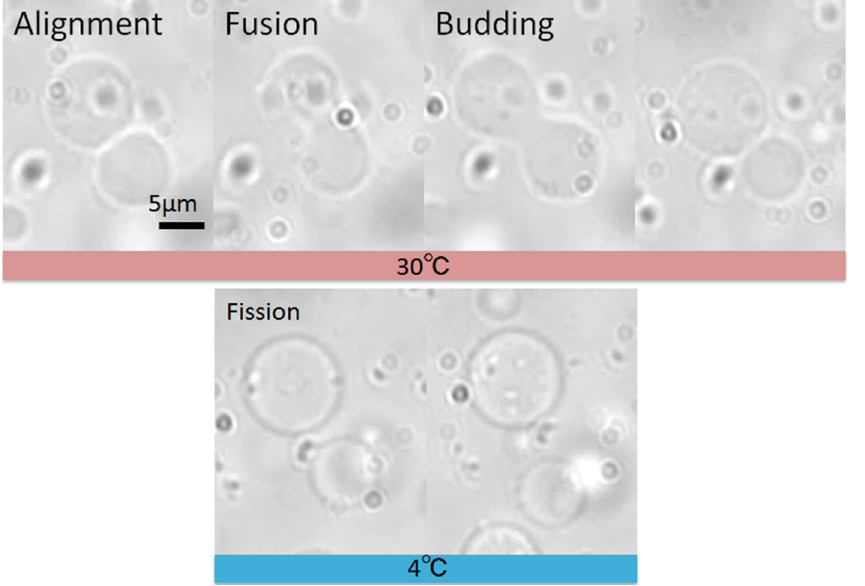
Figure 3. Brightfield micrographs showing the fusion, budding, and fission processes of GUVs. Fission (complete detachment) of daughter GUVs after budding was induced by lowering the temperature close to the T m of the lipids.